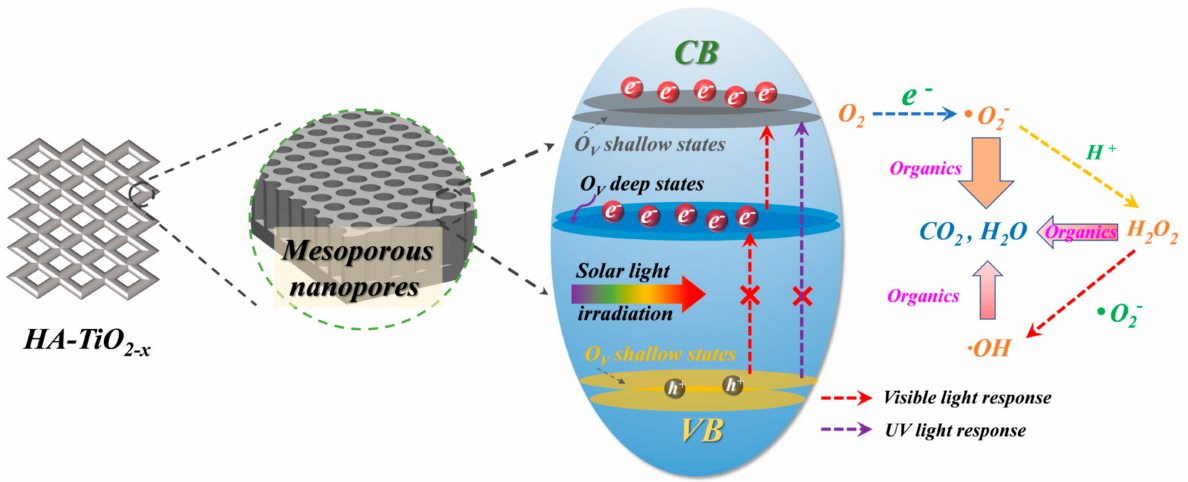
Figure 12. Proposed schematic diagram of visible–light photoactivity for HA-TiO 2 − x